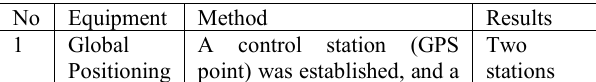
Table 2.1 The types of instruments used in data acquisition